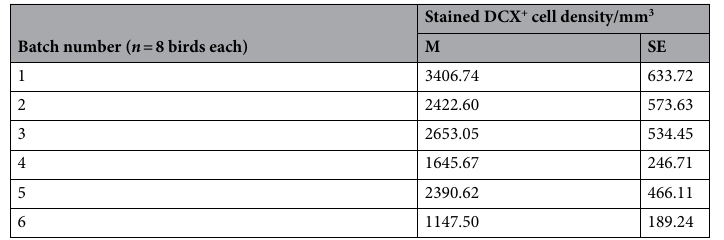
Table 3. Mean (M) and standard error (SE) for estimated densities of doublecortin (DCX) + cells of all types (combined multipolar and bipolar morphologies) stained over the whole HF of the adult hens in each of the 6 immunohistochemistry processing batches (balanced for housing systems & body conditions), reflecting technical variation.